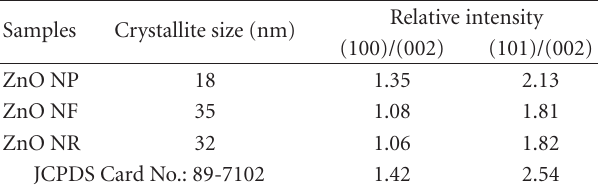
Figure 2: XRD patterns of ZnO nanoparticles, nanoflowers, and nanorods morphology. Table 1: Parameters calculated from XRD